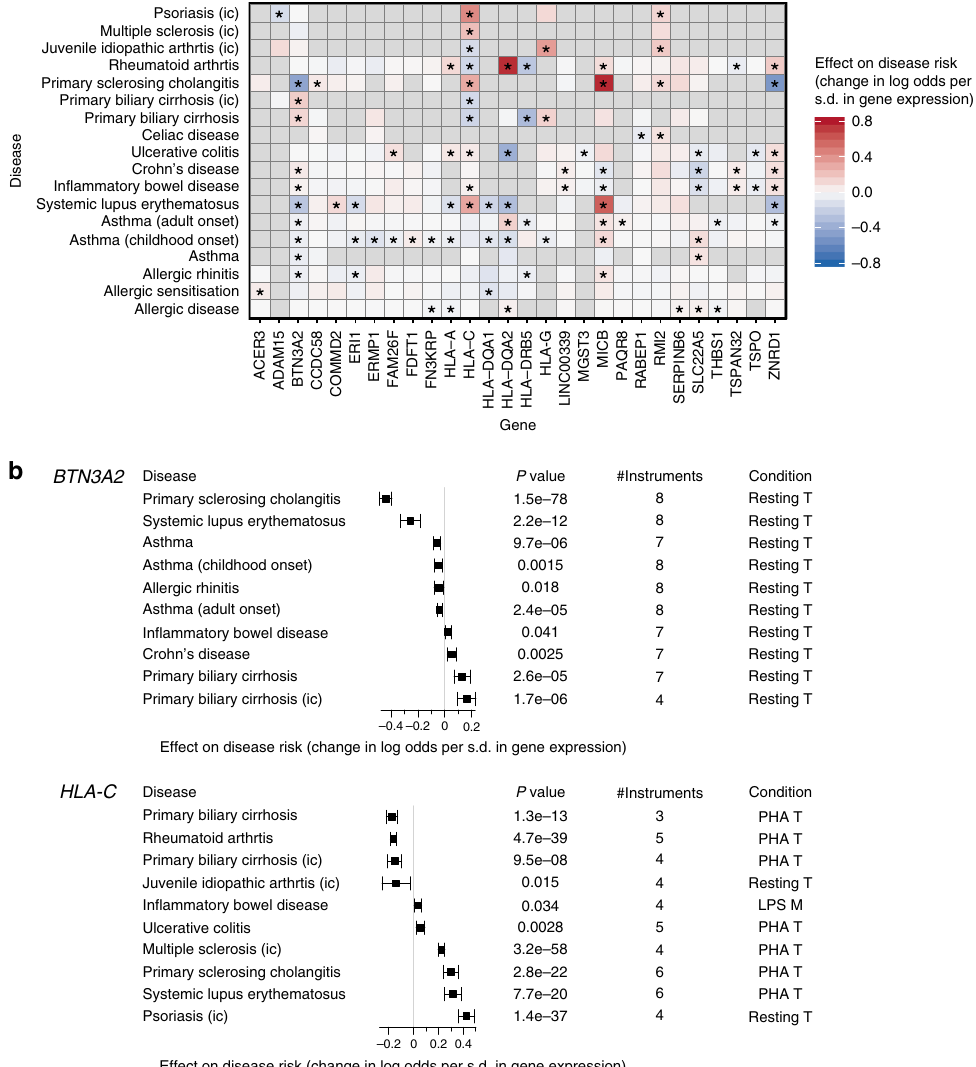
Fig. 5 Causal effects of neonatal gene expression on multiple immune-related diseases. The causal effects were estimated using the weighted mode method in the Mendelian randomisation (MR) analysis in both panels. Signi fi cant causal associations were de fi ned as having P -value ≤ 0.05 in at least three out of four MR methods ( ‘ Methods ’ ). Multiple testing correction was not applied. Causal associations with signi fi cant pleiotropy were excluded. If a gene was tested using the expression levels in multiple experimental conditions, the one with the highest number of genetic instruments was kept. Statistics of all MR tests are in Supplementary Data 5. a Asterisks indicate signi fi cant causal associations. Grey indicates the gene-disease pairs that were not tested due to small number of genetic instruments (<3). Positive effect estimates in red indicate that increased gene expression is causally associated with increased disease risk, and negative causal associations are in blue. b Forest plots present estimated causal effects on disease risk and its 95% con fi dence intervals for neonatal expression of BTN3A2 and HLA-C , using 125, 126, and 127 biologically independent samples from LPS-stimulated myeloid cells, resting T cells, and PHA-stimulated T